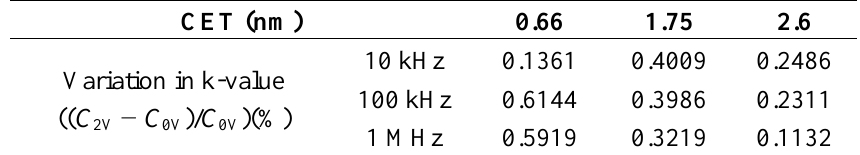
Table 3. Percentage of variation in the k-value with AC signal frequency for different CETs. Reprinted with permission from [43]. Copyright 2013 AIP Publishing